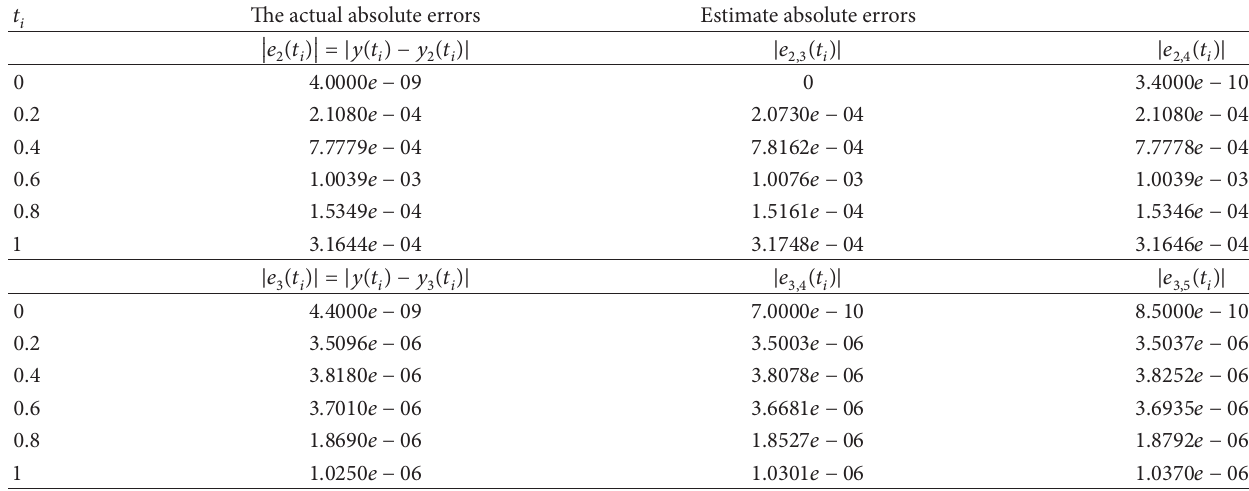
Table 1: Comparison of the actual and estimate absolute errors for 𝑁 = 2, 3 and